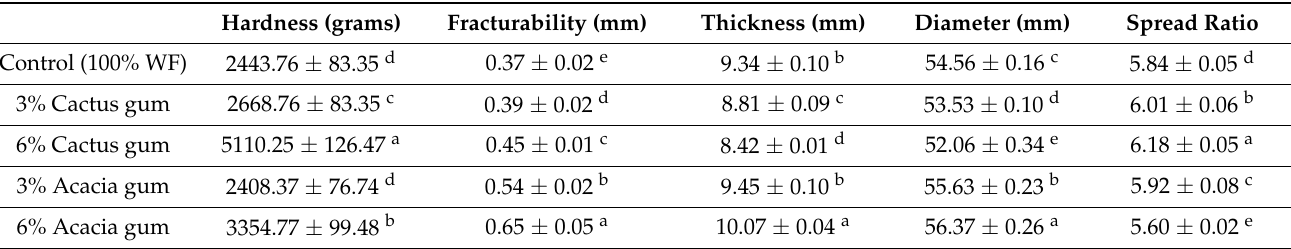
Table 3. Textural and physical properties of the